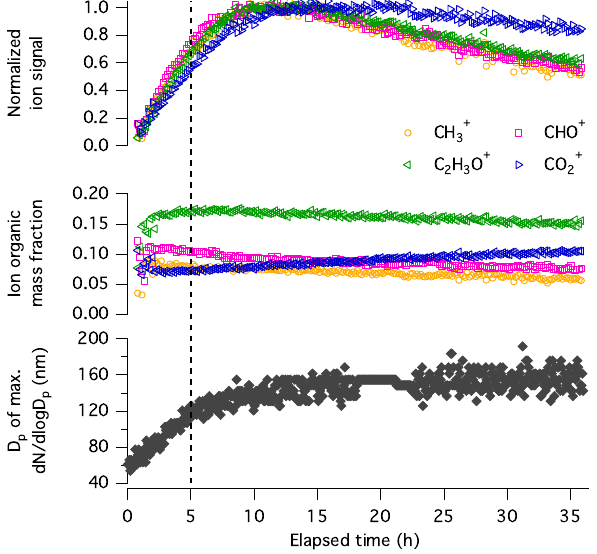
Fig. 7. Evolution of SOA chemical composition from high- resolution AMS measurements and diameter of the maximum num- ber distribution of suspended particles. In the top panel, the ion sig- nal is normalized by sulfate to account for particle wall losses. The sulfate-normalized ion signal is then scaled by the average value at the peak concentration. The middle panel shows the fractional contribution of each ion to the total organic mass signal. A relative ionization efficiency of 1.4 is used when calculating the organic ion concentration. The dashed line at 5 h corresponds to the reversal in trend of O:C.